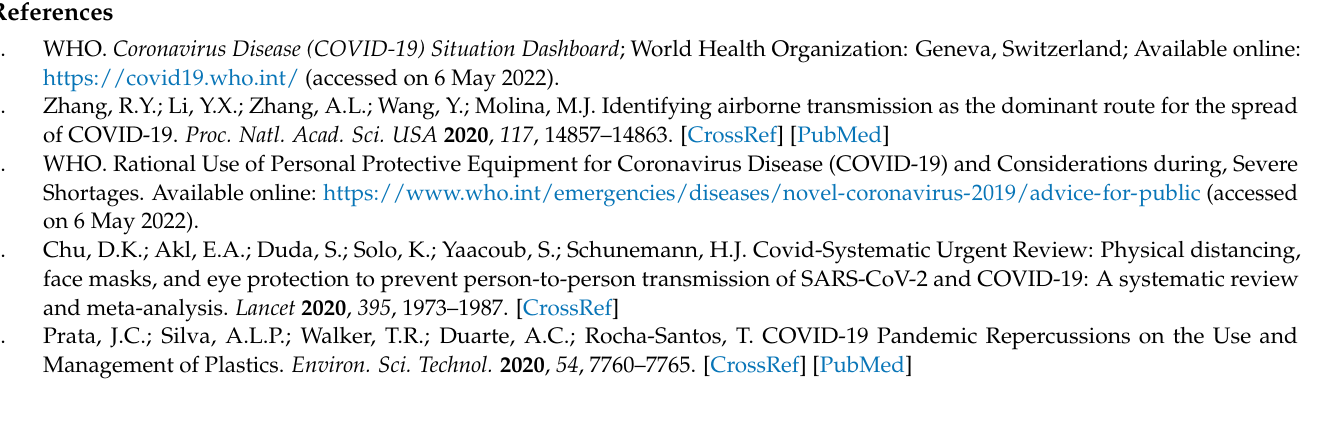
Figure S4: Quantity of fragments and fibrous microplastics of activated-carbon mask (AC), N95 mask (N95), surgical mask (SU), cotton mask (CO), fashion masks (FA) in indoor (IN) and outdoor (OUT) conditions after 24 h of suction; Figure S5: Size proportion of all microplastics after 24 h of suction in (a) indoor and (b) outdoor conditions; Figure S6: Five groups of microplastics collected from activated-carbon mask sample (AC), N95 mask sample (N95), surgical mask sample (SU), cotton mask sample (CO), fashion mask sample (FA), and blank sample (AIR) in indoor (top) and outdoor (bottom) conditions; Figure S7: Mass of phthalates in GFFs from indoor (IN) and outdoor (OUT) conditions after 24 h; Figure S8: Linear correlation of MPs quantity and ∑ 7 PAEs mass in (a) indoor and (b) outdoor conditions; Figure S9: Inhalation and dermal estimated daily intake of phthalates of an adult (a, c) and a child (b, d) and a child’s total estimated daily intake (e) while wearing activated-carbon mask (AC), N95 mask (N95), surgical mask (SU), cotton mask (CO), fashion mask (FA), and wearing no mask (AIR) in indoor and outdoor conditions. Table S1: Chemical properties of target PAE compounds; Table S2: Layers and materials of five types of masks in this study; Table S3: GC-MS Instrument parameters; Table S4: Mass spectrometry ions selected, retention time, and correlation coefficient in the analysis of 7 phthalates in this study; Table S5: Microplastics detected on different blank filters. Table S6: Estimated parameter values of dermal exposure to PAEs; Table S7: Recoveries, limits of detection (LODs), and quantification (LOQs) of GC-MS analysis of PAEs in mask and GFF samples; Table S8: Background concentration of phthalates (PAEs) in different types of masks (ng/g); Table S9: Quantity of fiber-like microplastics on GFFs indoors and outdoors (items/GFF) during inhalation; Table S10: Quantity of fragmented microplastics on GFFs indoors and outdoors (items/GFF) during inhalation; Table S11: Quantity of microplastics on GFFs indoors and outdoors (items/GFF) during inhalation; Table S12: Parameters and R 2 of each fitting model of microplastics in indoor conditions; Table S13: Parameters and R 2 of each fitting model of microplastics in outdoor conditions; Table S14: Correlation parameters of microplastic size and ∑ 7 PAE mass in indoor and outdoor